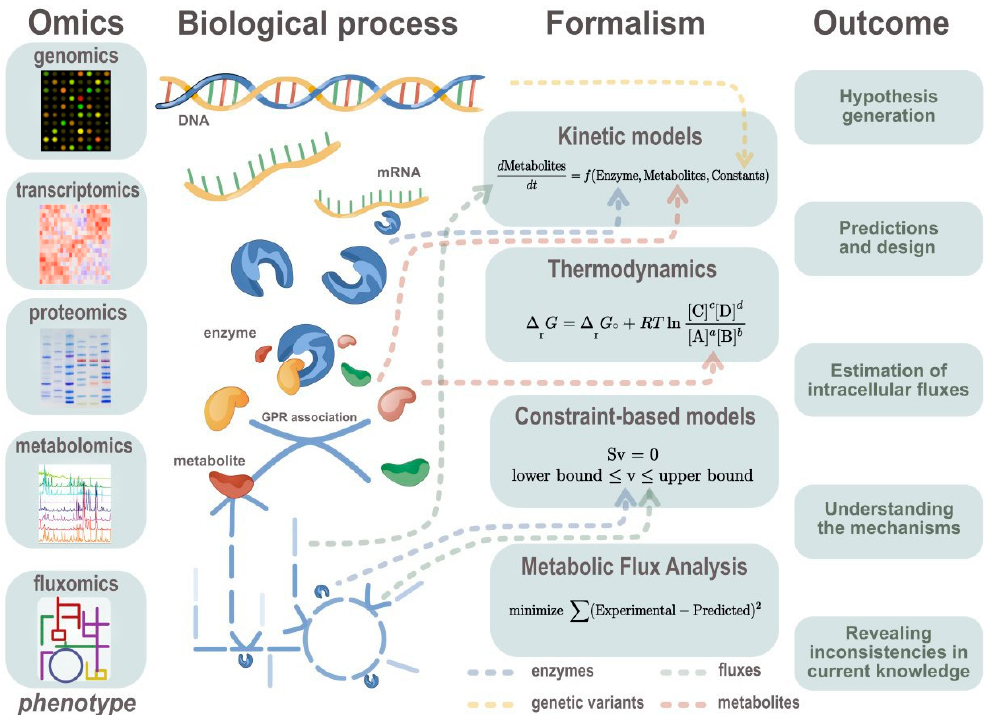
Figure 3. Description of reviewed approaches to integrate omics data and the outcome of the modelling methods. Different omics data types can be generated in order to study different metabolism phenomena. Those omics data correspond to different layers of cell functioning. Collected omics data can be formalized in different modelling approaches as different layers of the hierarchical organization of biological systems. Conventional ways of integration are shown with arrows pointing to the equation part. The typical outcomes of the modelling approaches described in this review are highlighted.